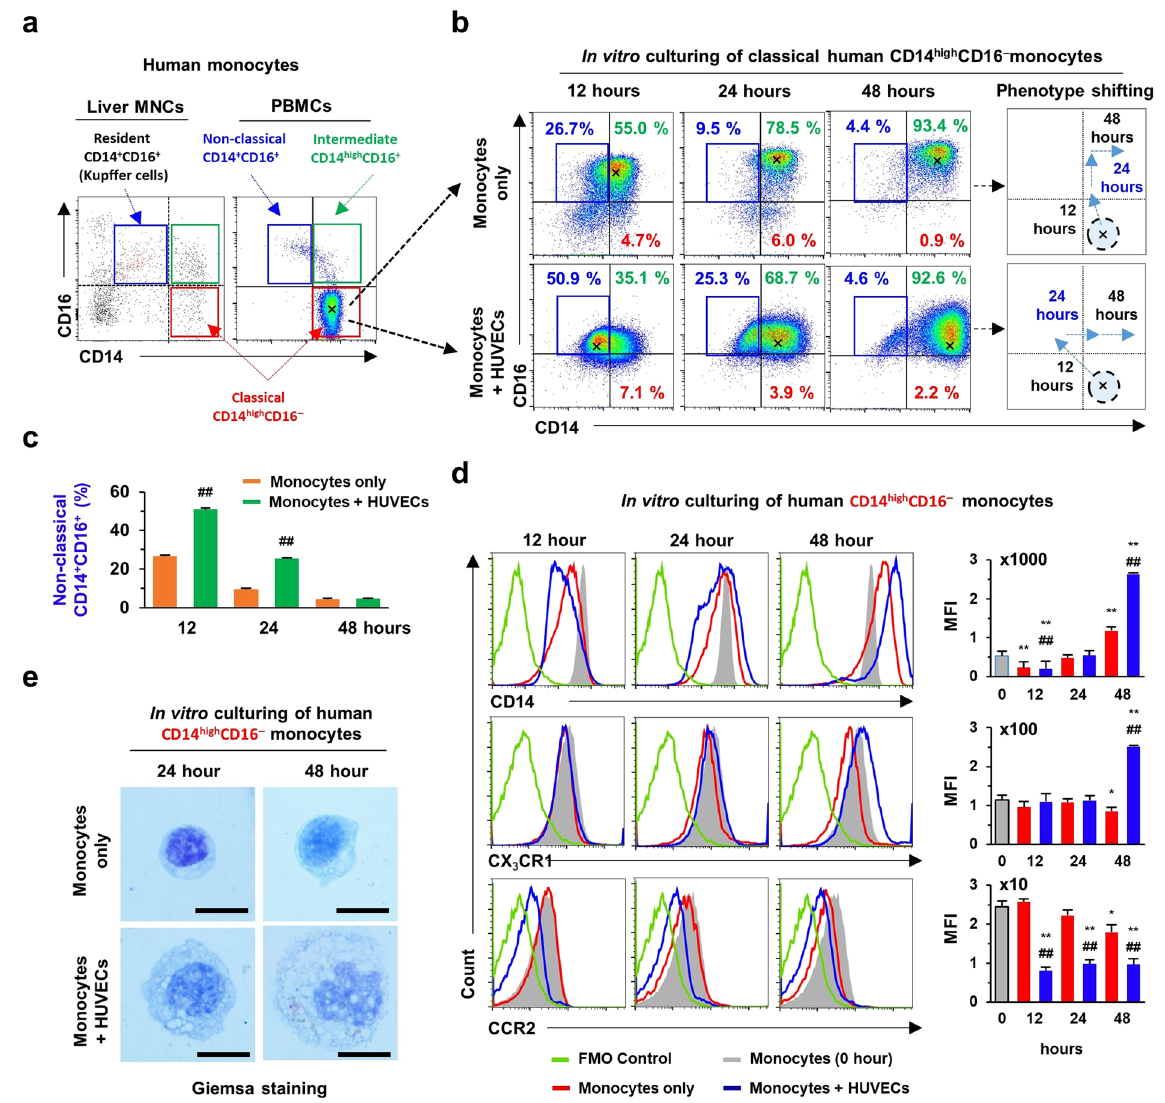
Figure 3. Human umbilical vein endothelial cells (HUVECs) differentiate human CD14 high CD16 − monocytes into CD14 + CD16 + monocytes along with high expression of CX 3 CR1. ( a ) Specific monocyte subsets were separated in human liver MNCs and peripheral blood mononuclear cells (PBMCs). ( b , c ) Human CD14 high CD16 − monocytes were co-cultured with HUVECs for 48 h. Then, their phenotypic shifts with respect to the expression of CD16 and CD14 were analyzed by flow cytometry and indicated by arrows and asterisks. Data are expressed as the mean ± SEM. # p < 0.05, ## p < 0.01 compared to corresponding monocytes only ( d ) Expression of CD14, CX 3 CR1 and CCR2 in cultured CD14 high CD16 − monocytes were analyzed by flow cytometry and compared to those of human liver monocyte subsets. Data are expressed as the mean ± SEM. * p < 0.05, ** p < 0.01 compared to 0 h. # p < 0.05, ## p < 0.01 compared to corresponding monocytes only. ( e ) Morphological changes of co-cultured CD14 high CD16 − monocytes were assessed after Giemsa staining. Bar = 10 μ m. The results represent three independent